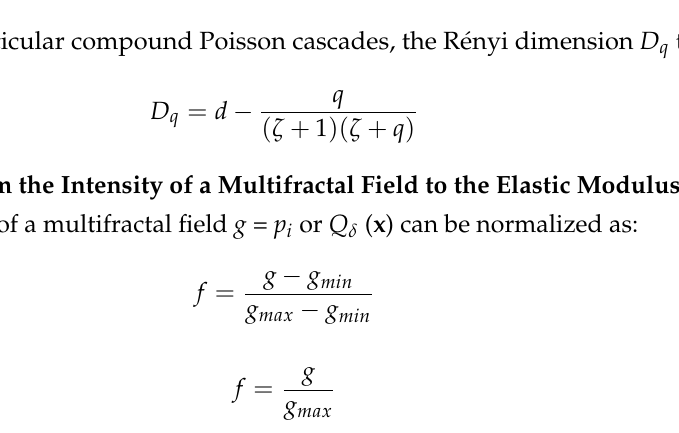
Figure 4. The random multipliers chosen for a particular family of compound Poisson